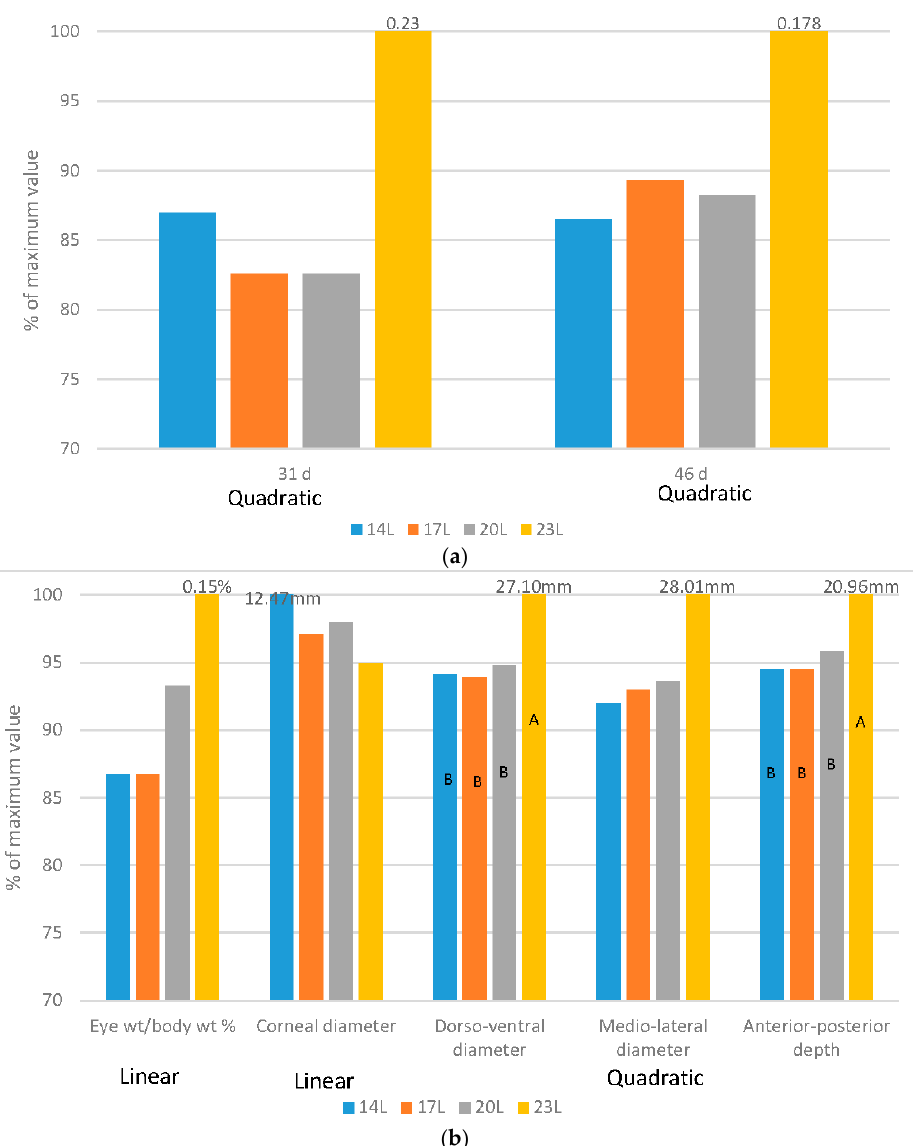
Figure 5. Effect of daylength on ocular measures. ( a ) Comparison of broiler relative eye weight (g/kg body weight) at 31 or 46 d of age under four daylength photoperiods, with data expressed as a percentage of the maximum value within each age; ( b ) Comparison of turkey ocular